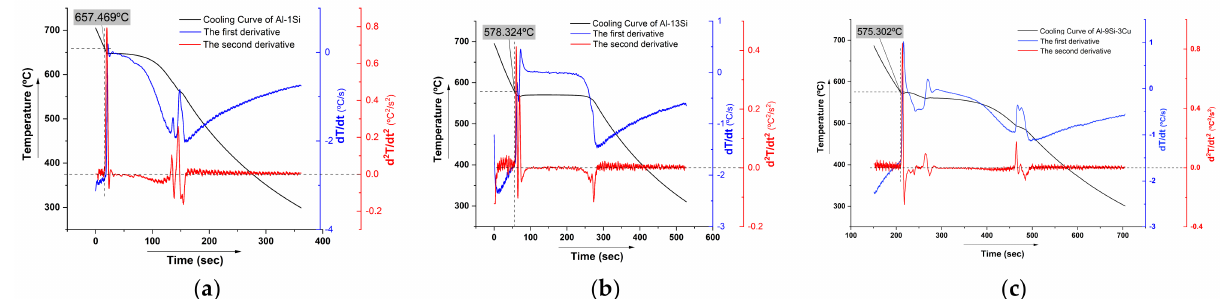
Figure 1. The measured nonequilibrium cooling curves and their first and second derivatives of filler alloys: ( a ) Al-1Si; ( b ) Al-13Si; ( c )Al-9Si-3Cu, where their compositions are presented in Table 1.